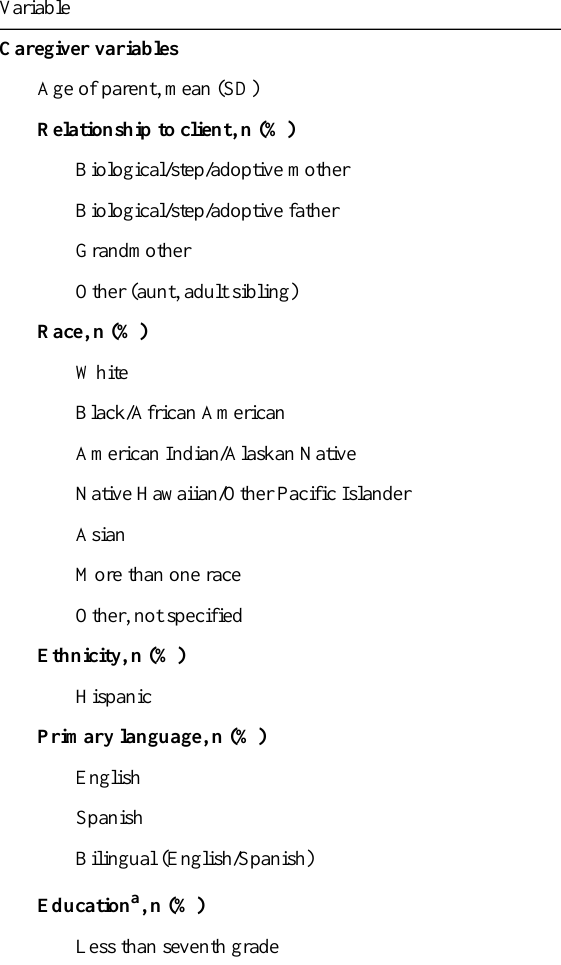
Table 1. Caregiver and child demographics